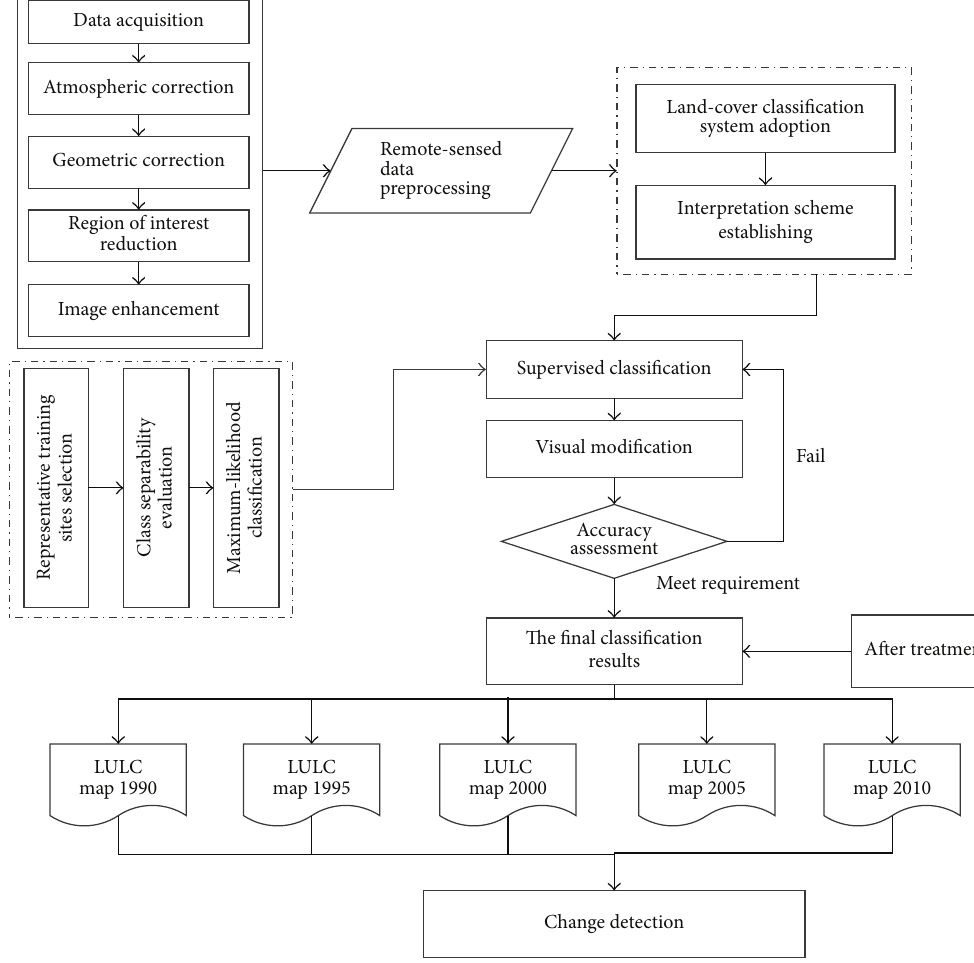
Figure 2: Flow chart of detection procedure of LULC